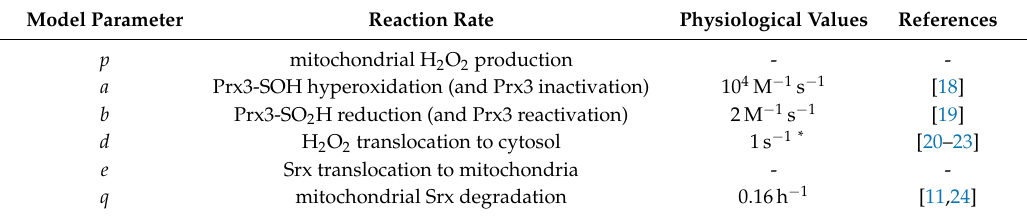
Table 1. Physiological parameter constraints that allow finding plausible parameter ranges in the peroxiredoxin (Prx) 3/sulfiredoxin (Srx) oscillating system. The rates of Prx3 hyperoxidation ( I formation), Srx-mediated Prx3 reduction (rescue of A ), and Srx degradation ( R removal) have been determined by enzymatic assays in previous studies. The rate of mitochondrial H 2 O 2 translocation * is estimated from experimental and theoretical studies that have focused on H 2 O 2 transport and